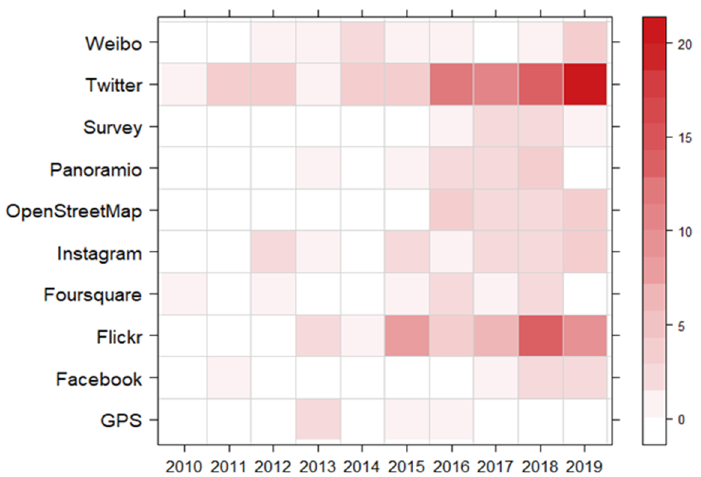
Figure 4. The frequency of occurrence of different data platforms found in the UGS and social media literature.